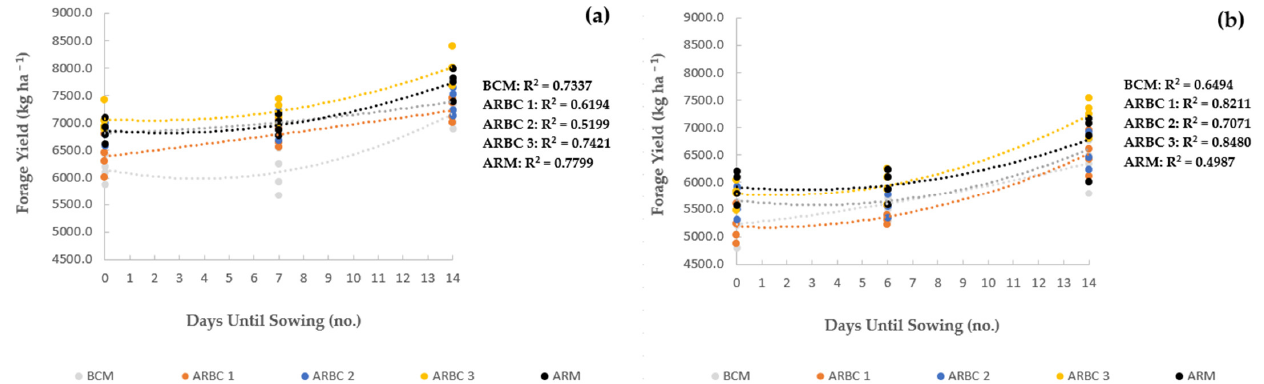
Figure 5. Second-degree polynomial relationships (y = ax 2 + bx + c, n = 12) between forage yield